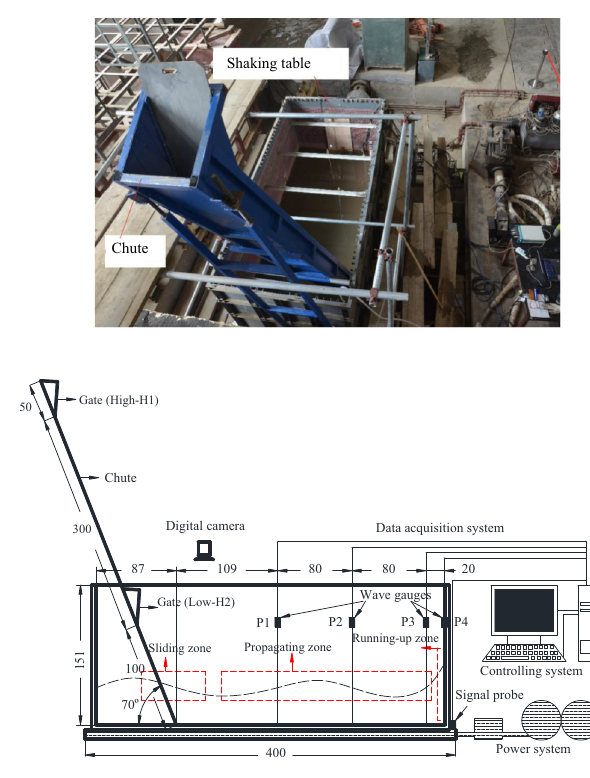
Fig. 2 Schematic diagram of experimental